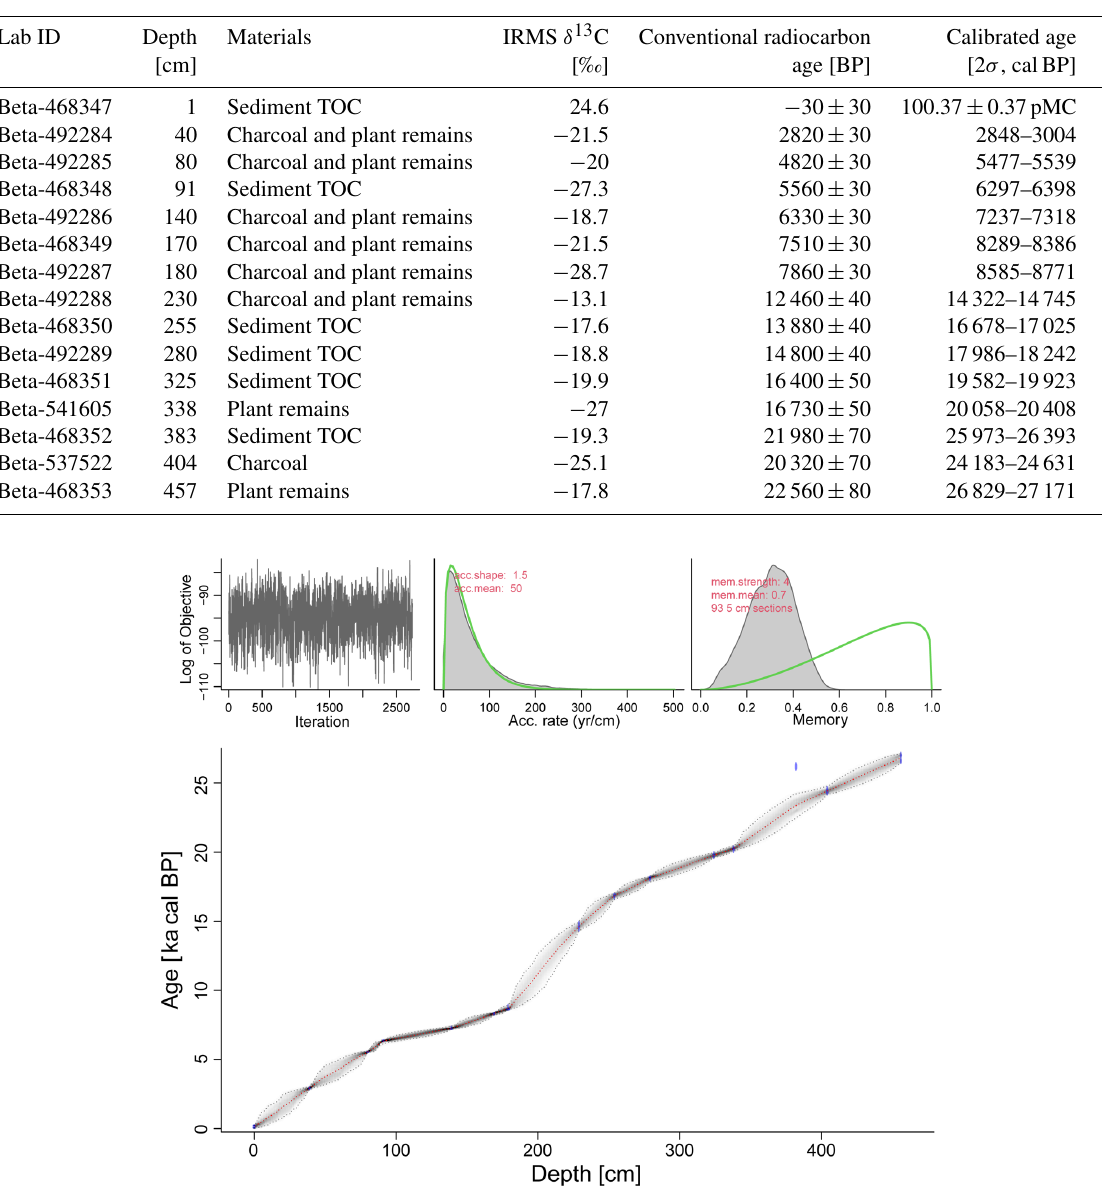
Figure 2. Age–depth model of the sediment core